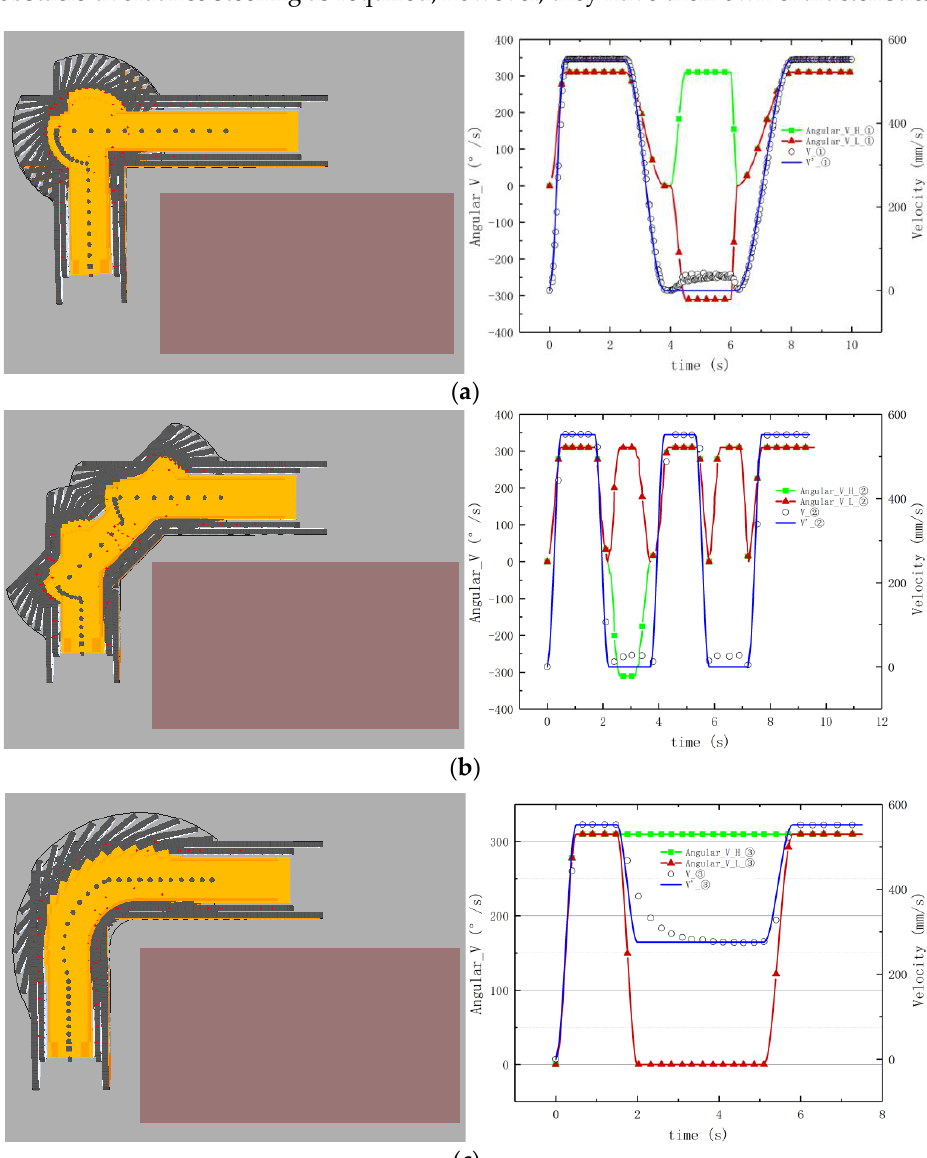
Figure 8. Angular obstacle-avoidance steering simulation. ( a ) Obstacle-avoidance steering motion shown in scheme 1 (10.2 s); ( b ) Obstacle-avoidance steering motion shown in scheme 2 (9.4 s); ( c ) Obstacle-avoidance steering motion shown in scheme 3 (7.5 s).